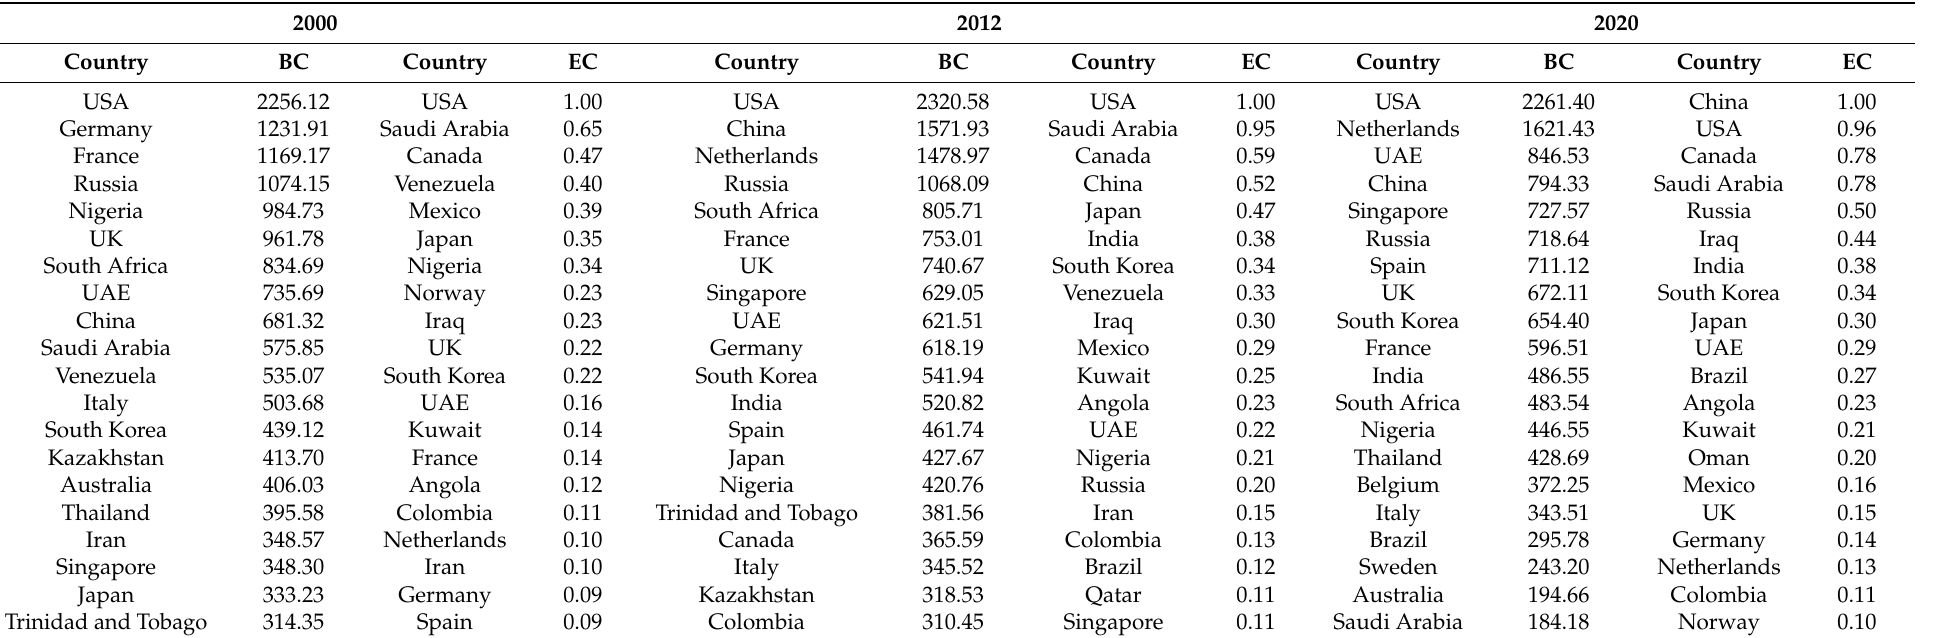
Table 2. Top 20 countries for Centrality indicators of Global Crude Oil Trade